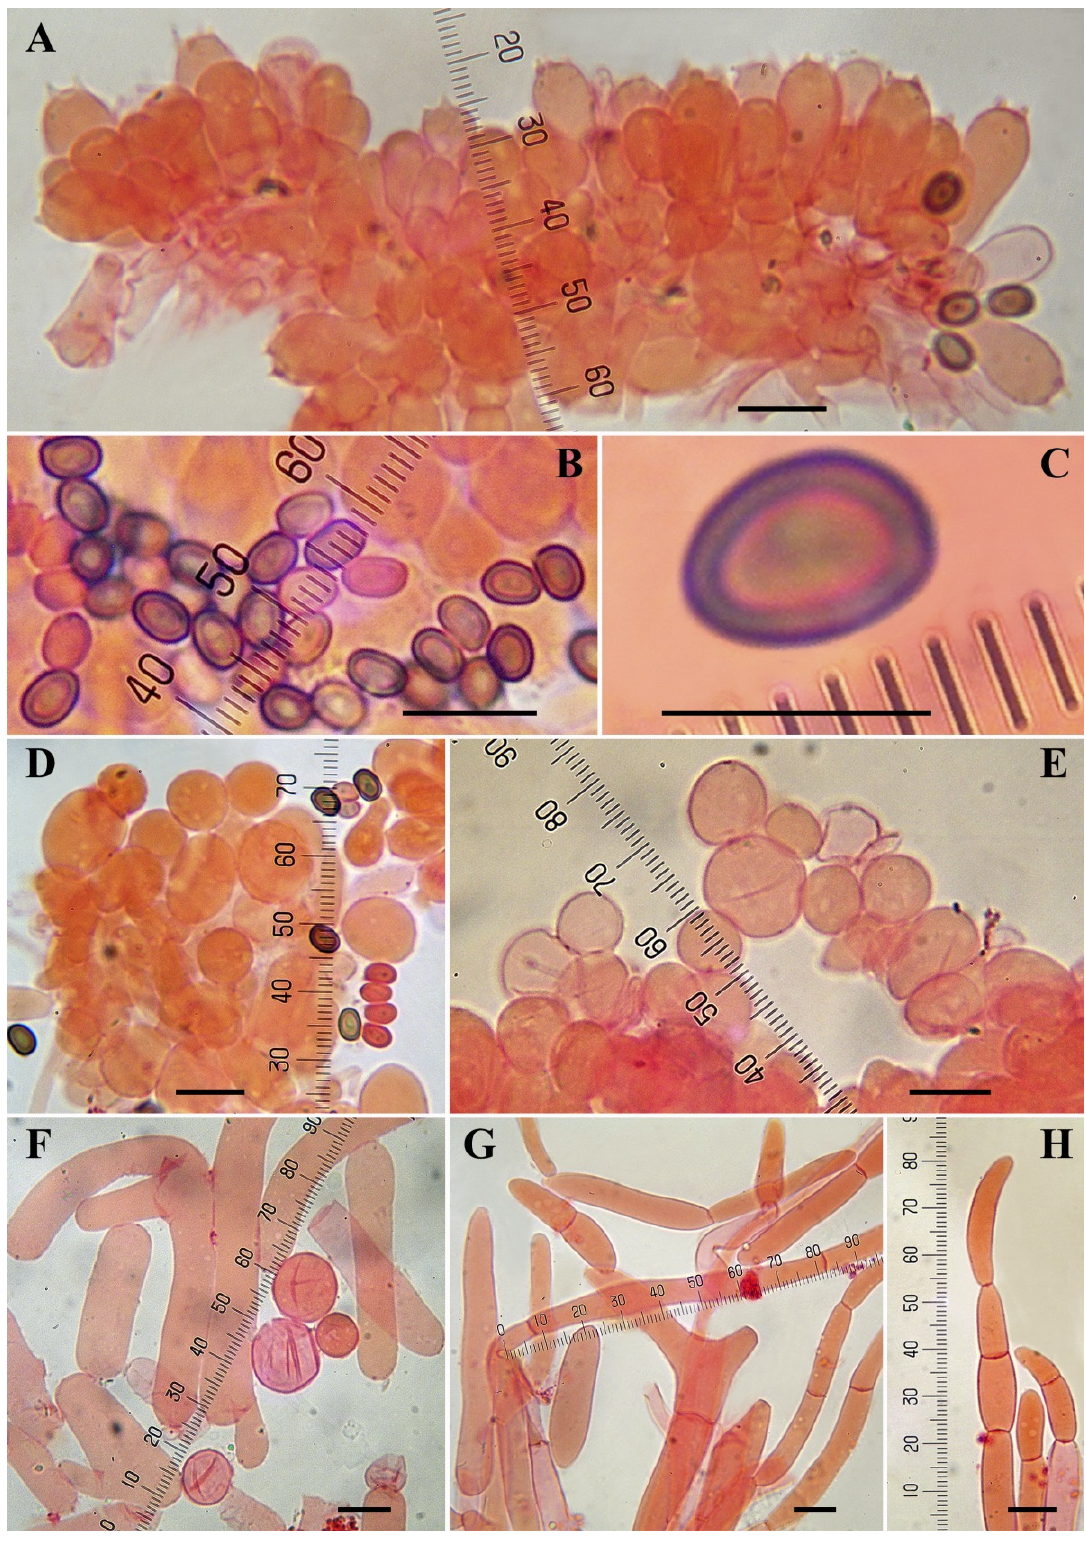
Figure 8. Microscopic characters of Agaricus subrufescens from Dominican Republic. ( A – H ) In ammonical Congo red (LAPAM78). ( A ) Basidia; ( B , C ) Spores; ( D , E ) Cheilocystidia; ( F ) Hyphae of the lower surface of the annulus; ( G , H ) Pileipellis hyphae; ( H ) Terminal element. Bar = 10 μ m. Photos by L.A. Parra.